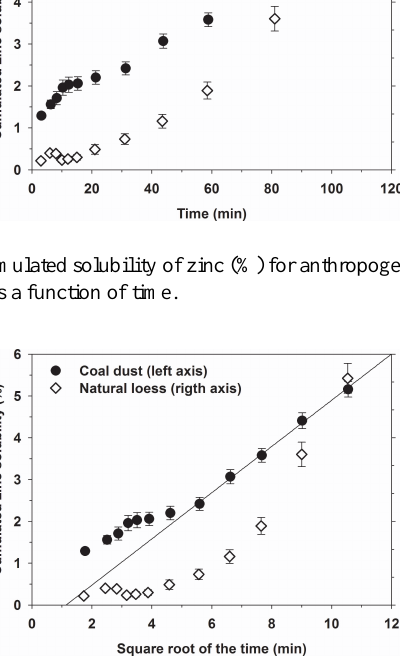
Table 4. Extrapolation of the linear correlation between the disso- lution of Co (top) and Zn (bottom) as function of the square root of the time. 100% means total dissolution of the metal in seawater.